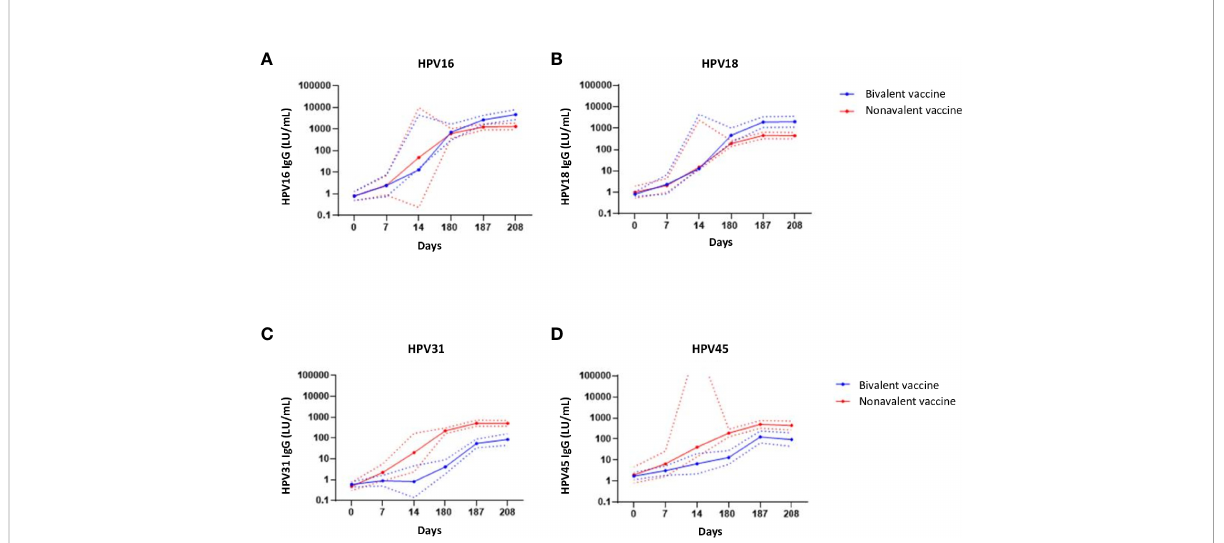
FIGURE 5 IgG antibody responses. IgG antibodies concentrations (Luminex units/mL blood) speci fi c for (A) HPV16 , (B) HPV-18, (C) HPV-31 and (D) HPV- 45 upon bivalent (blue) and nonavalent (red) vaccinations at day 0, 7, 14, (post fi rst vaccination) and day 180, 187 and 208, respectively 0, 7 and 28 days post third vaccination. The lines represent the geometric mean concentrations (GMCs) over time per vaccine cohort. The dotted lines represent the upper and lower limit of the 95% con fi dence interval of the geomean. At day 180, participants received the third HPV vaccination. The high upper limit in the nonavalent group for HPV45 is due to the measurement of antibodies at day 14 instead of day 7 in just two donors, which gave a high